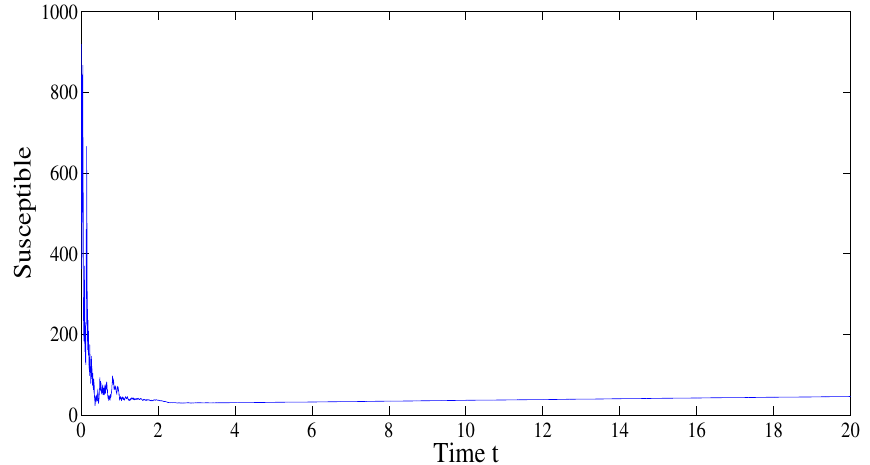
Figure 2. The Susceptible population as a function of time when λ = 10, µ = 0.0125, β = 0.0001, γ 2 = 1, γ 1 = 0.1, (cid:101) = 0.33, δ = 0.09 and d =